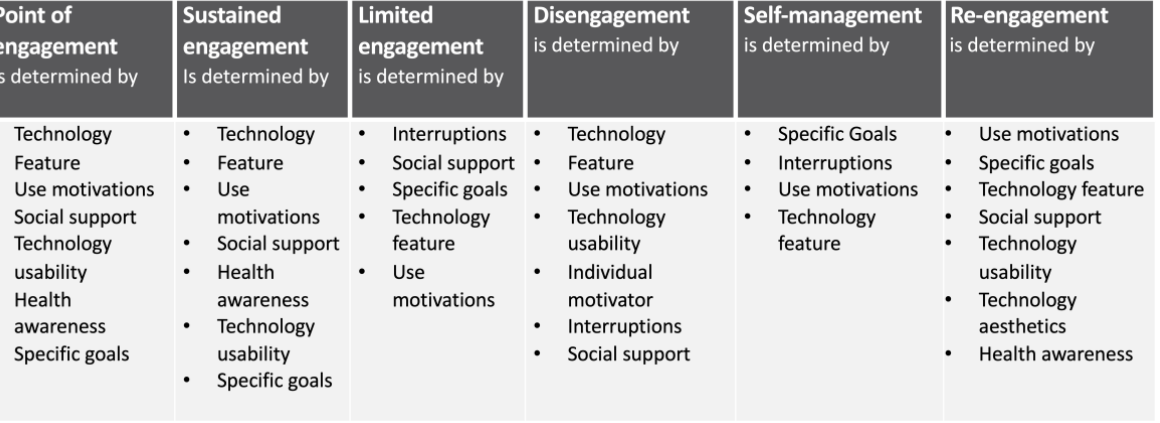
Figure 3. Themes relevant at each engagement